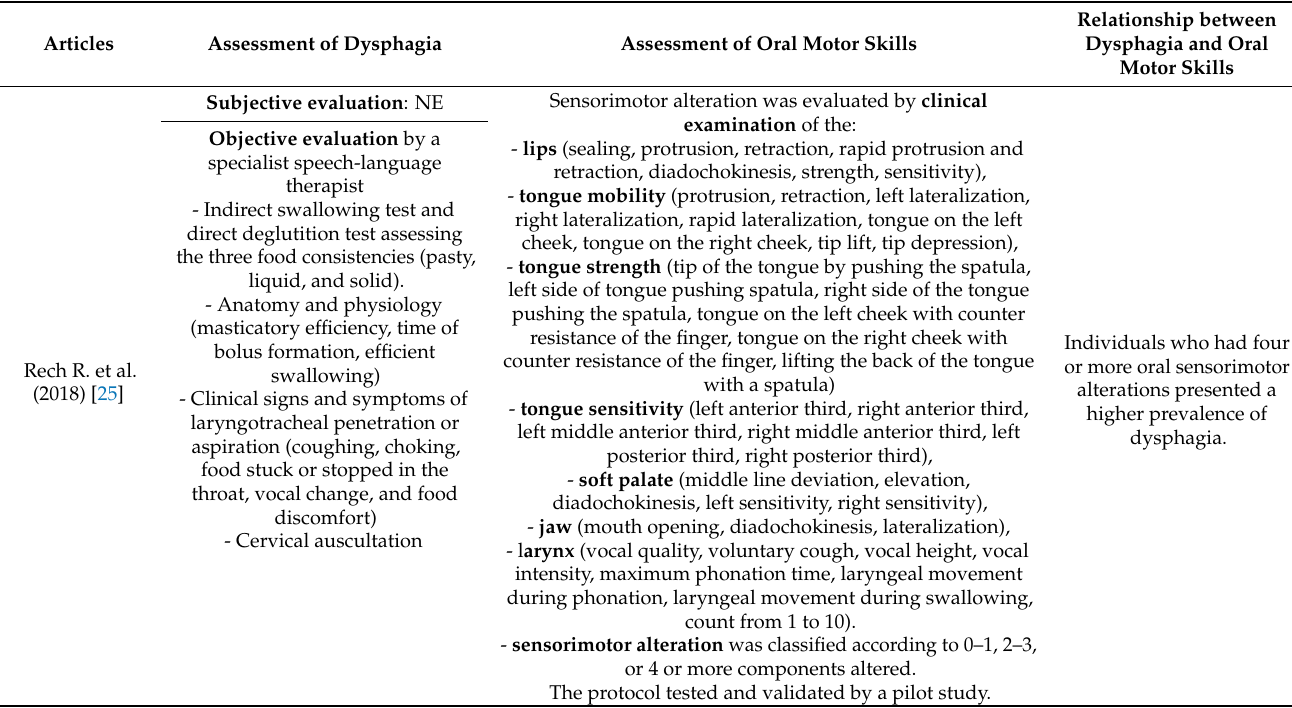
Table 4. Criteria used to establish the link between oral motor skills and